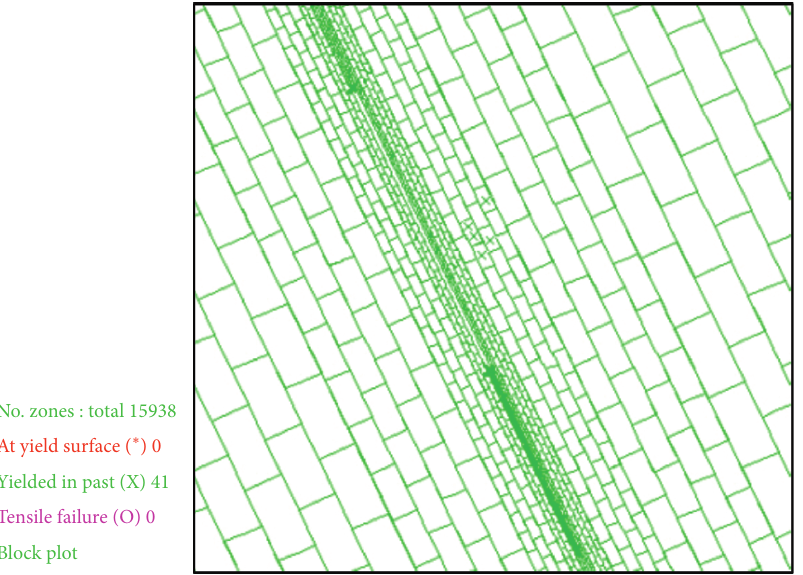
Figure 16: Surrounding rock failure pattern with 120m stope height (caving